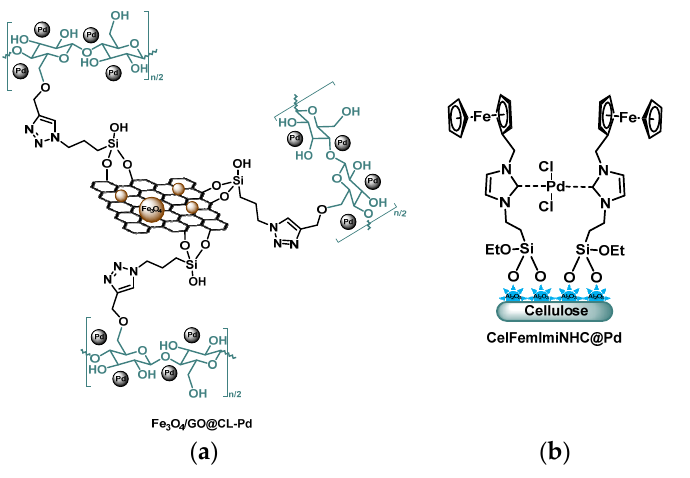
Figure 7. ( a ) Palladium supported on cellulose modified Fe 3 O 4 -graphene oxide [62]; ( b ) cellulose– alumina composite supported Fc–NHC Pd(II) complex [63]. alumina composite supported Fc–NHC Pd(II) complex